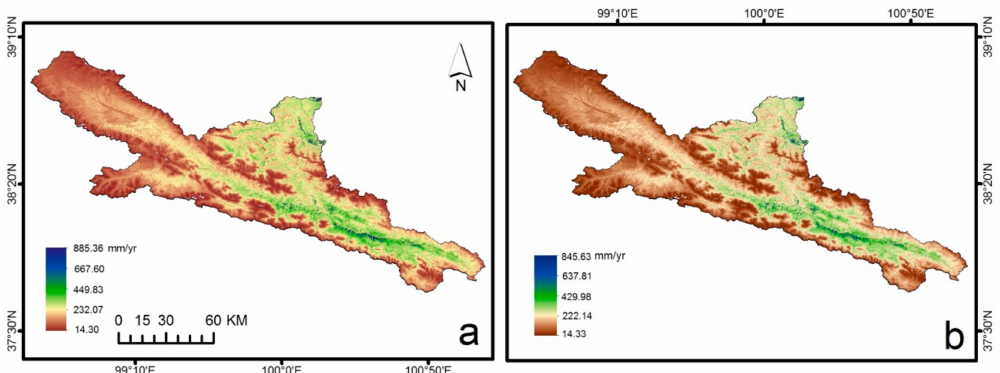
Figure 8. Simulated spatial patterns of annual total ET for 2013 ( a ) and 2014 ( b ) in the Upper Heihe